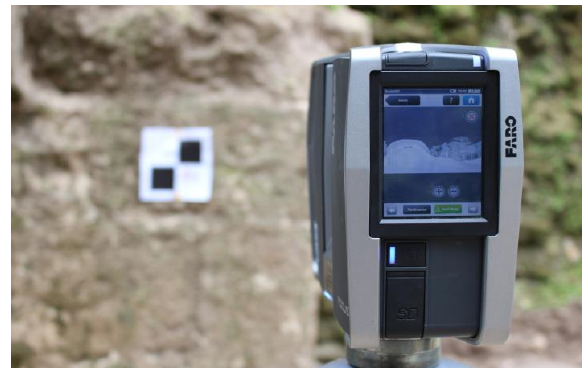
Figure 4. Data capture with a FARO Focus 3D S120 laser scanner, using bidimensional reference targets. (Project La Blanca